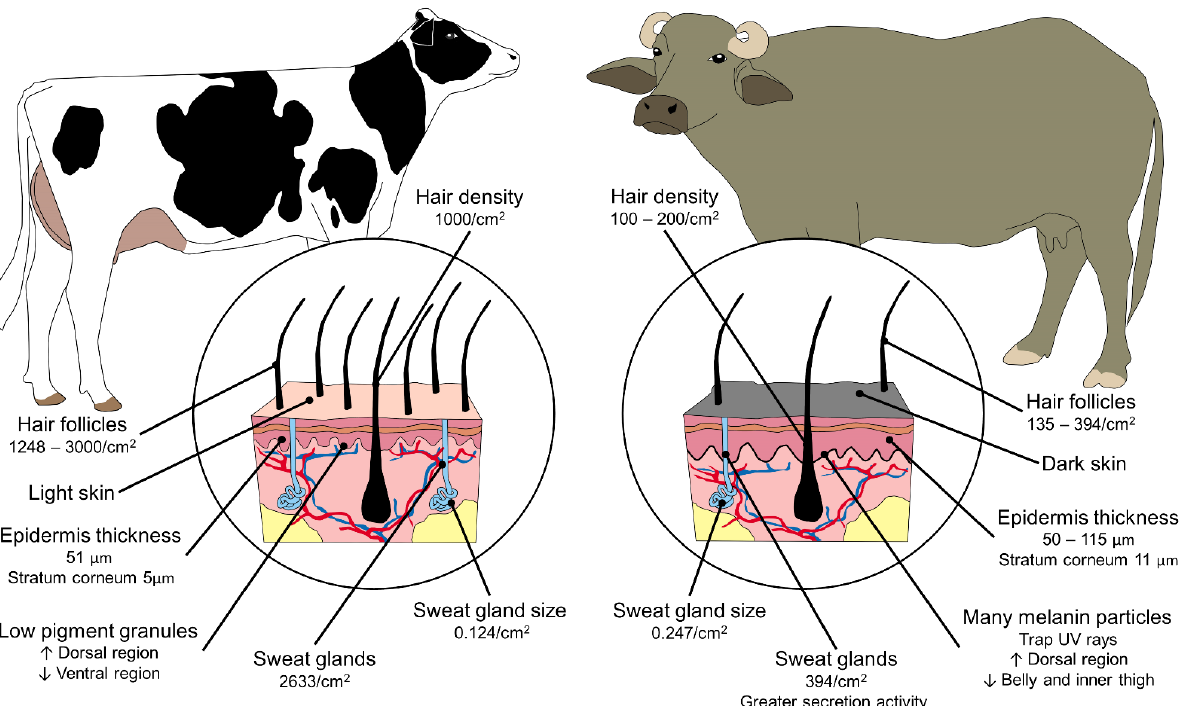
Figure 9. Morphological differences in skin characteristics between cattle ( Bos taurus and Bos indicus ) and river buffaloes ( Bubalus bubalis ). The skin and structures involved in the thermoregulation of buffaloes (number of hair follicles, hair density, epidermis thickness, melanin concentration, number and size of sweat glands) differ significantly from those in cattle, and influence the deficient thermoregulation mechanism of this species [104–107].